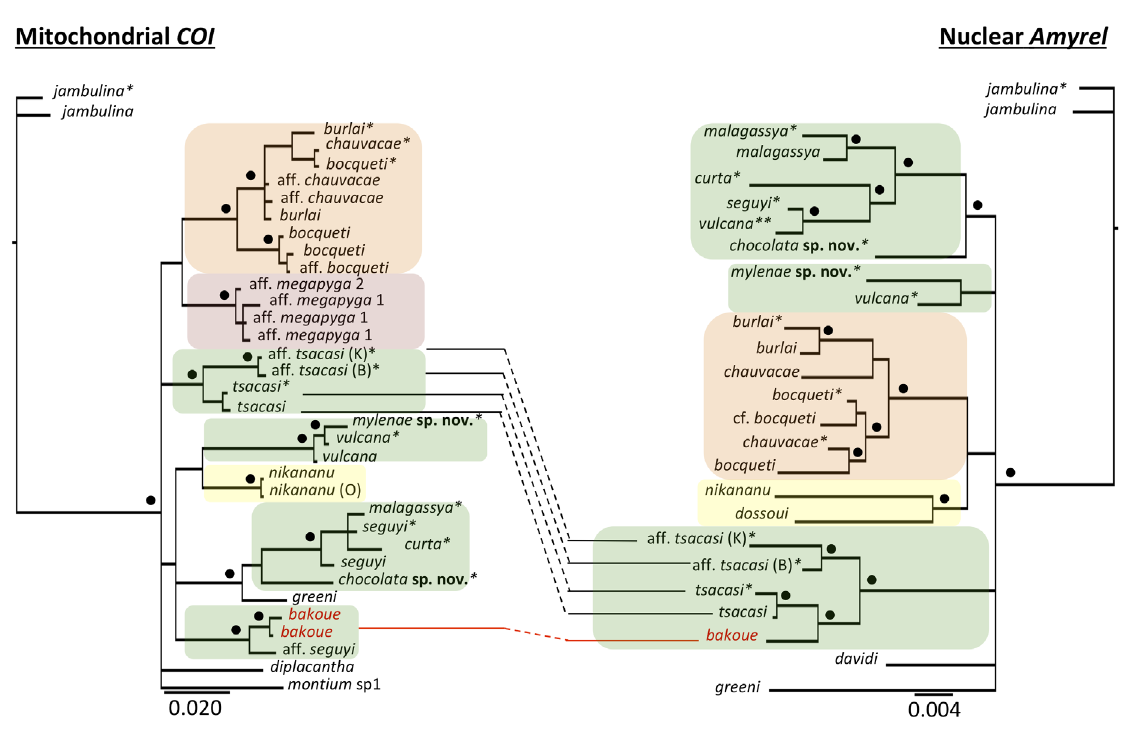
Fig. 2. Comparison of Bayesian phylogenies of the ‘ D. seguyi species subgroup’ Yassin, 2018 inferred from mitochondrial COI (left) and nuclear Amyrel (right) genes. Nodes supported by >95% posterior probability (pp) are labeled with black circles. An asterisk refers to species sequenced here, whereas two asterisks refer to the sequence of D. vulcana Graber, 1957 of Da Lage et al. (2007), which turned out to belong to D. seguyi Smart, 1945 from Kenya (see the text). Note the discrepancy in position of different geographical strains of D. bakoue Tsacas & Lachaise, 1974 (in red) between the two genes. Species belonging to ‘ D. bocqueti species complex’ Tsacas & Lachaise, 1974, ‘ D. bakoue species complex’ Rafael, 1984, ‘ D. nikananu species complex’ Tsacas & Chassagnard, 1992, and ‘ D. megapyga species complex’ Lachaise & Tsacas, 2001 are highlighted in orange, green, yellow and red,